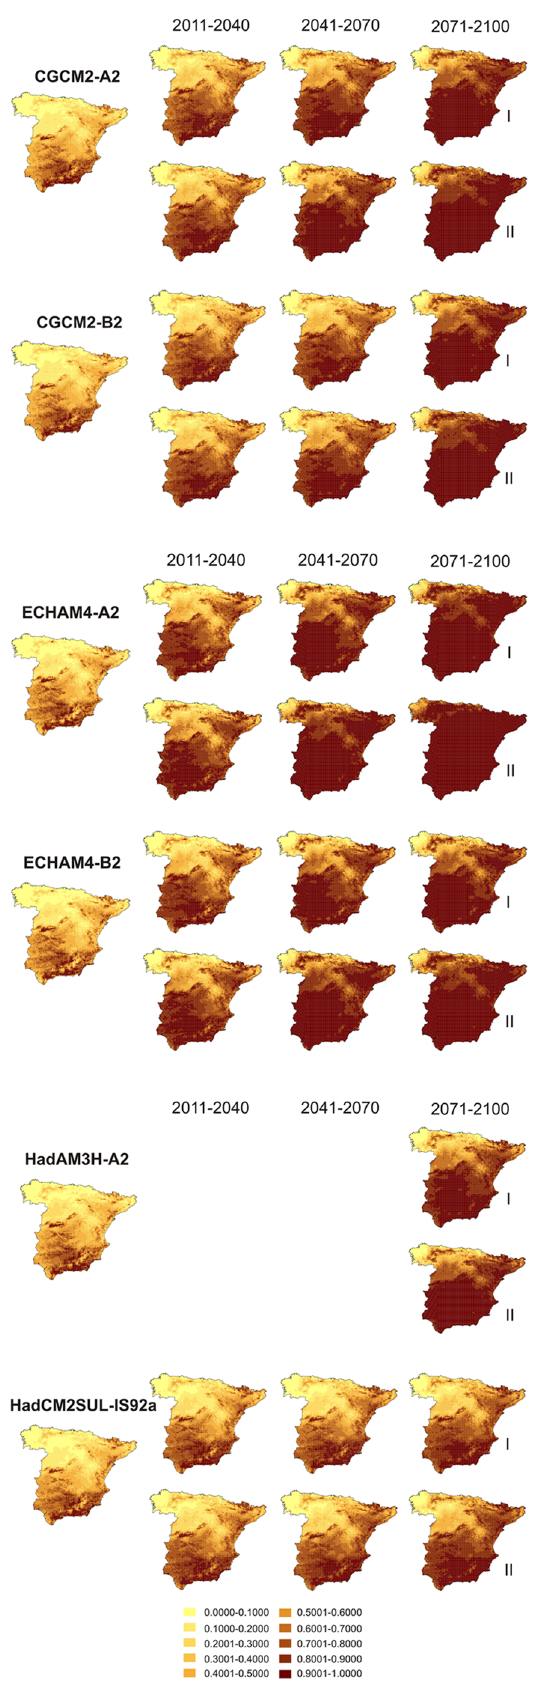
Figure 1. Favourability values forecasted at each 10 km 6 10 km UTM square of mainland Spain for Bonelli’s Eagle, according to each climatic model and for each considered period. I and II indicate the minimum and maximum expected change in favourability,